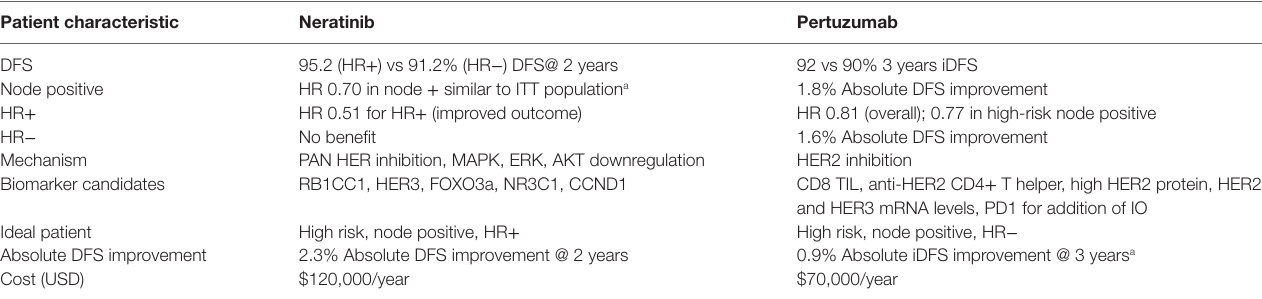
TABLE 2 | Patients benefiting in APHINITY and